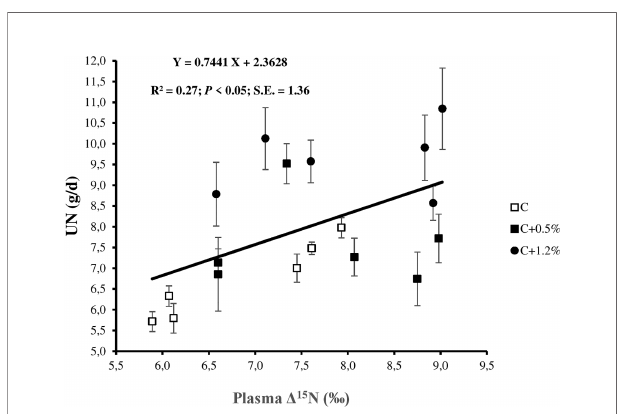
FIGURE 3 | Relationship between urinary nitrogen (N; UN) and plasma N isotopic discrimination (plasma D 15 N) for individual observations of the sheep offered three different levels of non-protein N: C, control dietary treatment with maintenance N intake (NI) allowance; C+0.5%, control dietary treatment with maintenance plus an additional 15% NI allowance; C+1.2%, control dietary treatment with maintenance plus an additional 33% NI allowance. The error bars show SE.